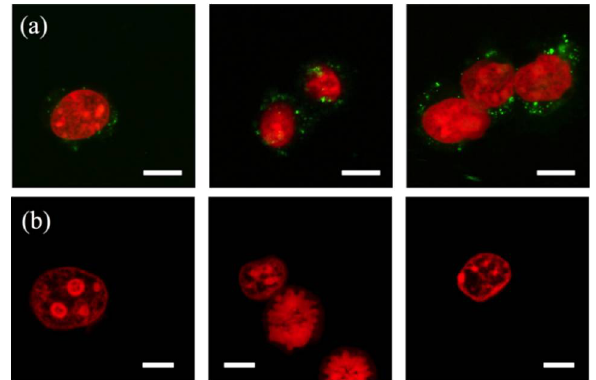
Figure 6. Confocal fluorescence images of the nuclei (red; propidium iodide (PI)-stained) from mouse embryo fibroblast (NIH / 3T3) cells isolated using ( a ) an eight-constriction treatment and ( b ) chemical lysis. The nucleus, and the nuclear doublet and triplet shown in ( a ) carry membrane fragments (green; DiOC18(3) (DiO)-stained). The constrictions are w = 10 µ m and d = 7 µ m. Scale bars are 10 µm.